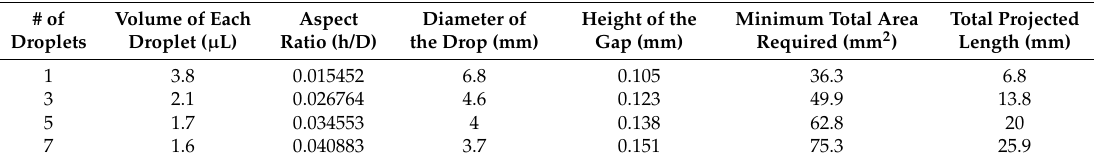
Figure 9. Case study 2: fixed stiffness (162 N/m) and fixed droplet diameter. The wetting areas (hydrophilic) are the shaded region. This case evaluates the impact on droplet volume and gap height when designing for stiffness. Table 3. Case study of droplet(s) with constant stiffness (162 N/m), the contact angle is 110 ◦ top and bottom. The diameter of the top wetting region is the same as in case study